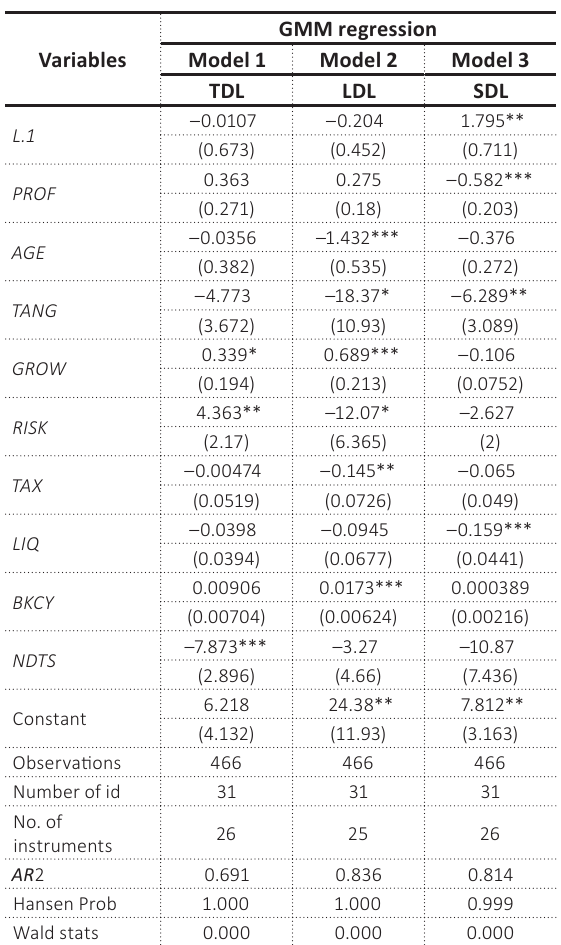
Table 4. Regression